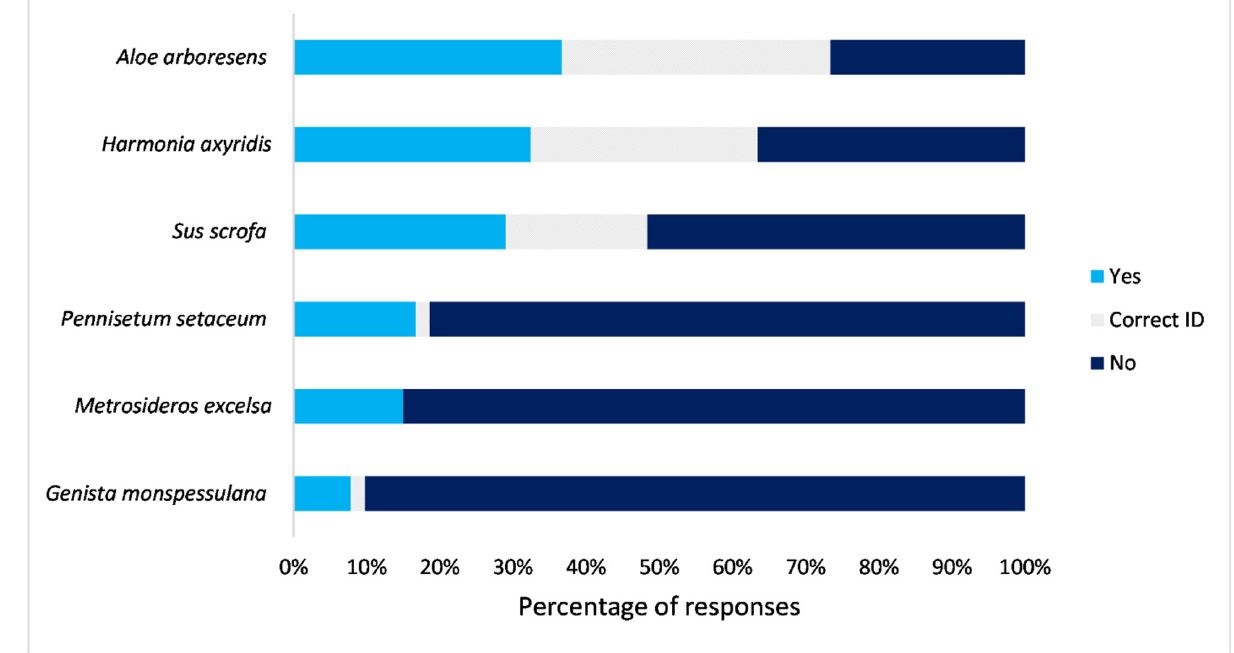
Figure 5. Number of respondents who knew the species in question were IAS or indigenous and the number who per- ceived each as beneficial or harmful. Aloe arborescens is indigenous to South Africa, and the rest of the species are invasive alien species found in the study region. Photo references—top row from left to right: Metrosideros excelsa Photo credit: South African National Biodiversity Institute, 2012; Genista monspessulana Photo credit: South African National Biodiver- sity Institute, 2010; Pennisetum setaceum Photo credit: Pinterest, accessed date: 30 November 2021, from: https://www.pin- terest.com.mx/adrian_leon_v/pennisetum-setaceum; Aloe arborescens Photo credit: Plant Info, accessed date: 30 Nov 2021, from: https://plantinfo.co.za/plant/aloe-arborescens; Sus scrofa Photo reference: Thai National Parks, accessed date: 30 No-